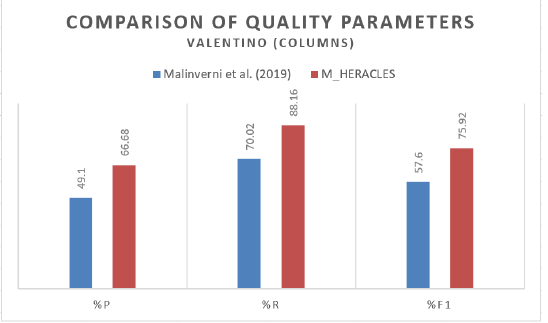
Figure 11. Histogram representation of the quality parameters for the Valentino dataset comparing the results of [36] against M_HERACLES for the column